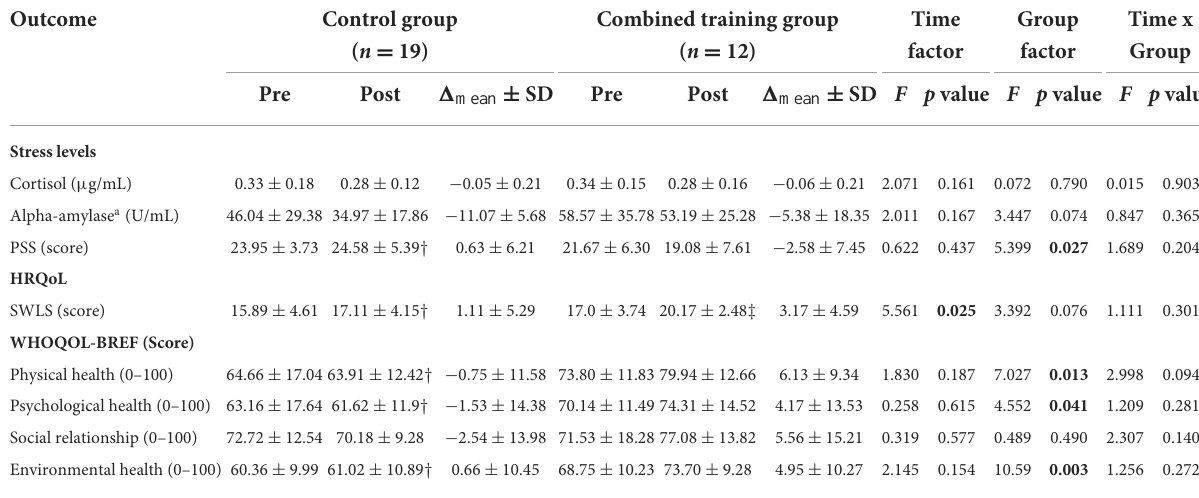
TABLE 3 Differences between baseline and 16-week follow-up and between groups on the salivary stress hormones and HRQoL, calculated with two-way ANOVA for repeated measures.